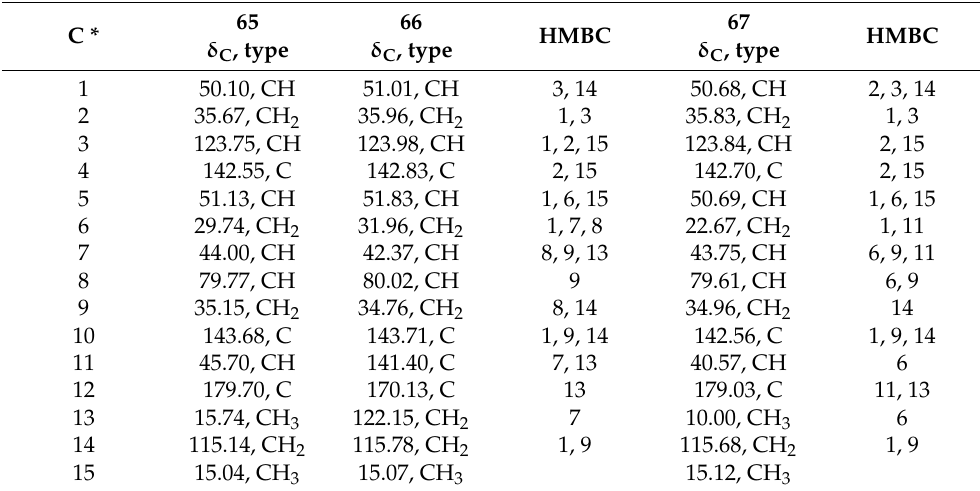
Table 2. 13 C-NMR data a,b in CDCl 3 for xantholide B 65 , ziniolide 66 , and 11 β -dihydroziniolide 67 .